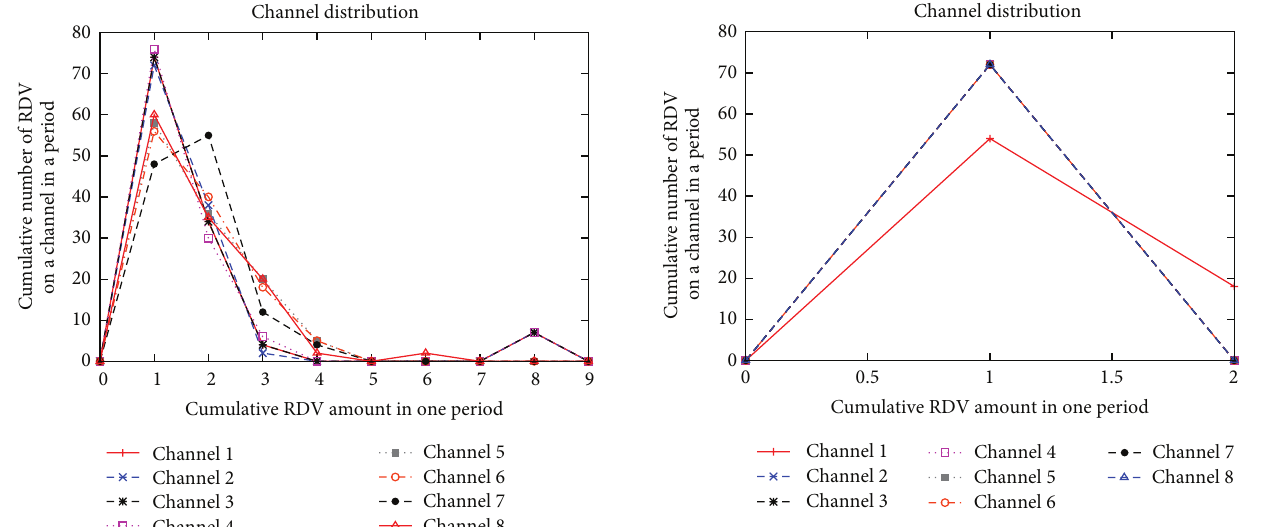
Figure 15: DSMMAC [13]: 8 channels (73